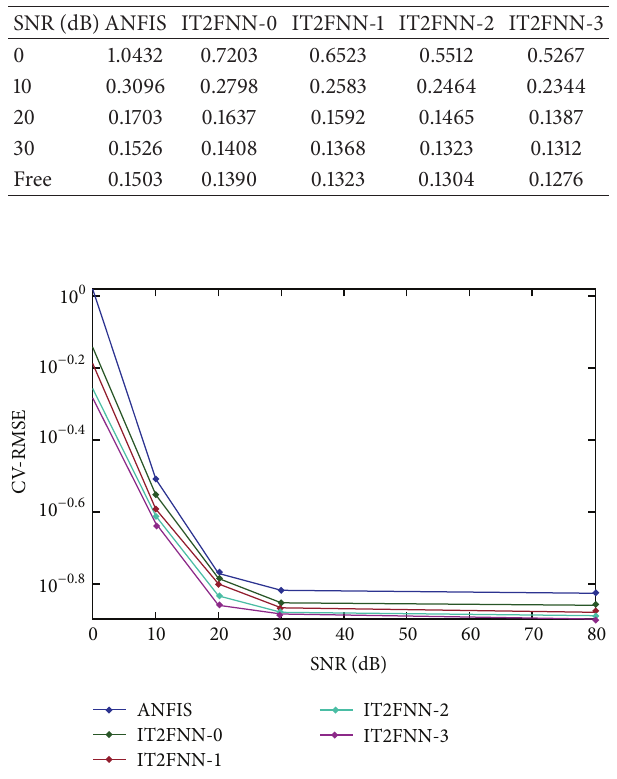
Figure 8: Resulting RMSE (CHK) values obtained by ANFIS and IT2FNNfornonlinearityidentificationinExperiment 2with10-fold cross-validation.